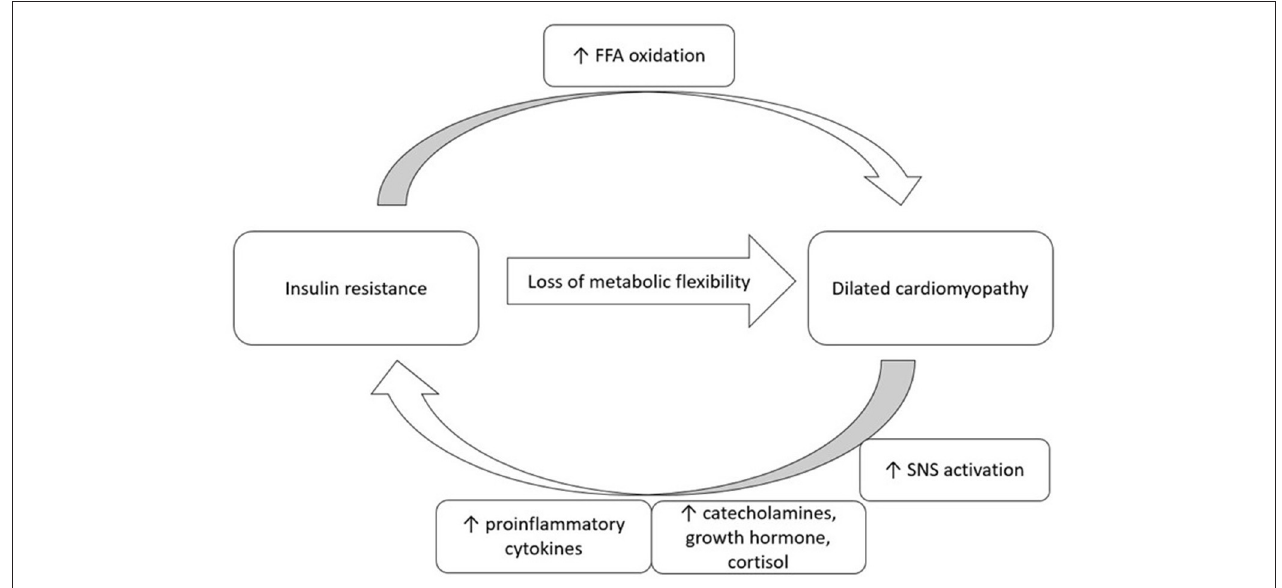
FIGURE 1 | A proposed bi-direction relationship of insulin resistance and dilated cardiomyopathy. FFA, free fatty acid; SNS, sympathetic nervous system.